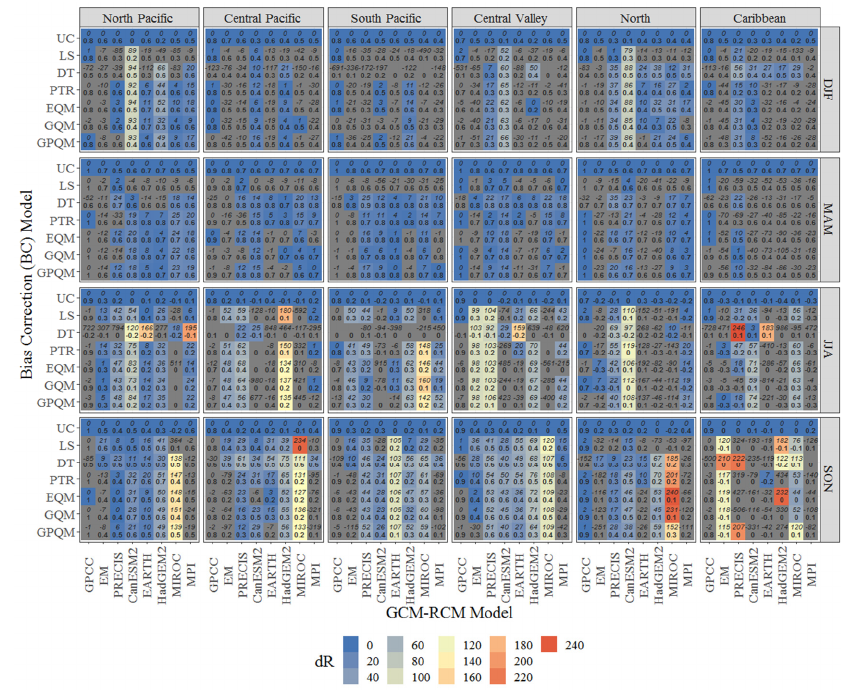
Figure 8. Spatially-averaged R performance of uncorrected and bias-corrected precipitation during the validation period 1981–1995 for all climatic regions of Costa Rica. Bold cell numbers represent absolute R values (unitless), whereas italic numbers and scale-color represent the R relative percentage change (%) after bias correction. Negative values are presented in grey. Water 2020 , 12 , 482